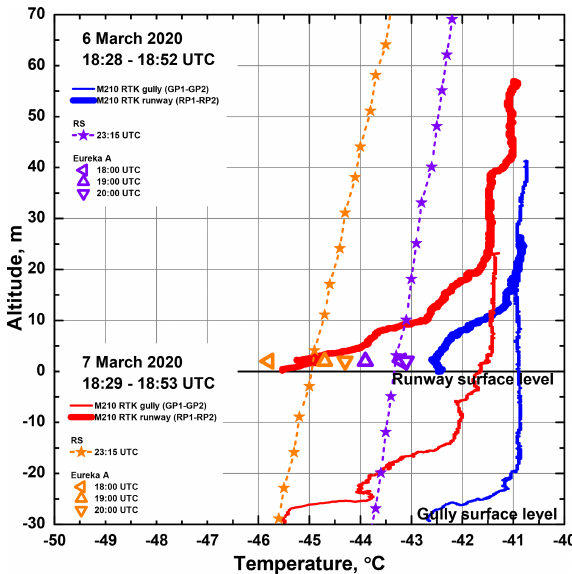
Figure 13. Temperature profiles measured during M210 RTK gully versus runway flights on 6 and 7 March 2020 featuring similar shapes of SBI formed in the gully and above the runway (see Fig. 7 for the locations of the temperature